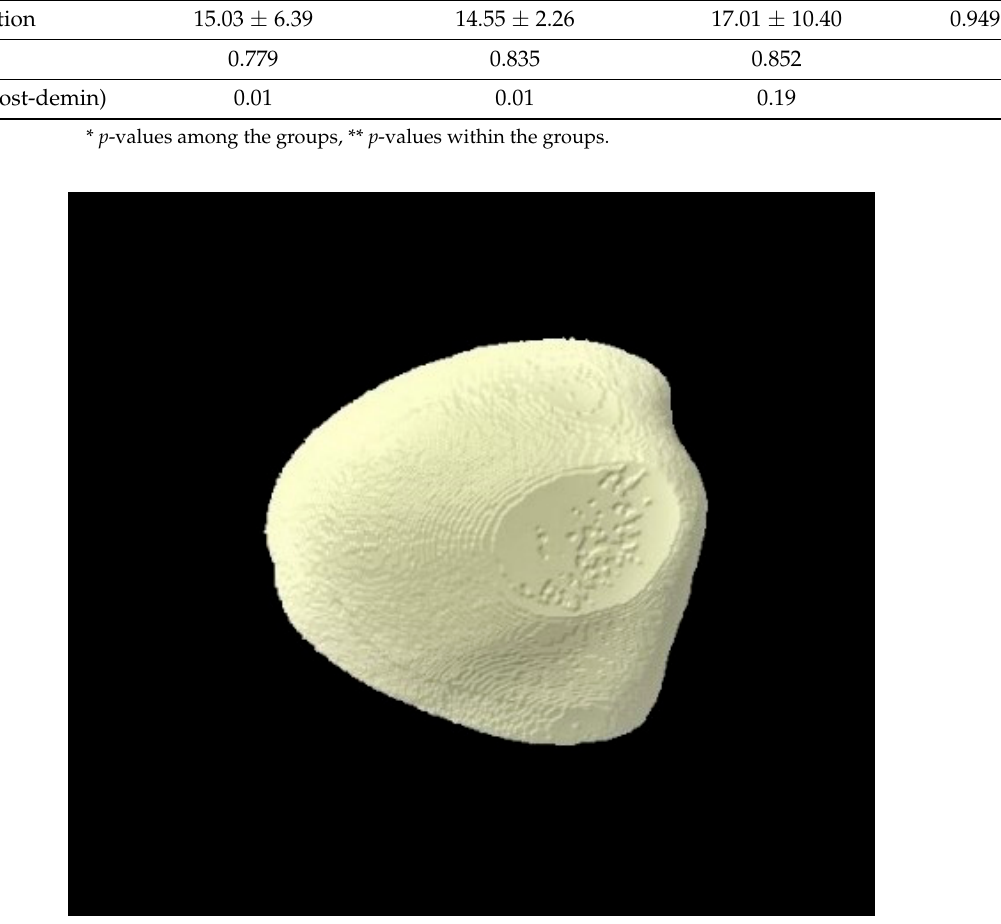
Figure 5. Micro-CT image of group 2 samples presenting enamel surface at baseline.